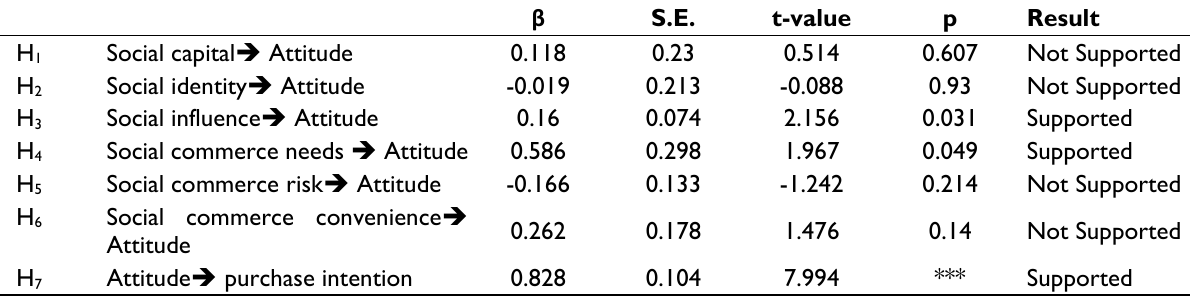
Table 4. Hypothesis Test